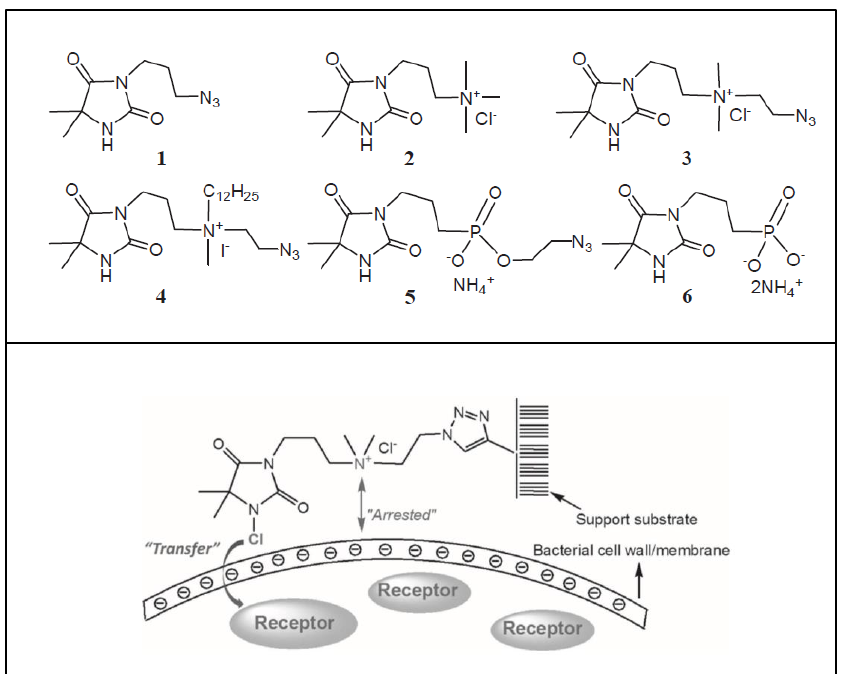
Figure 3. Schematic representations of several N -chloramine precursors containing either a quaternary ammonium moiety or a phosphonate functional group ( top ), and of an enhanced antimicrobial function between cationic groups and N -chloramine ( bottom ). Reproduced with permission from reference [54]. Copyright 2012 Wiley.